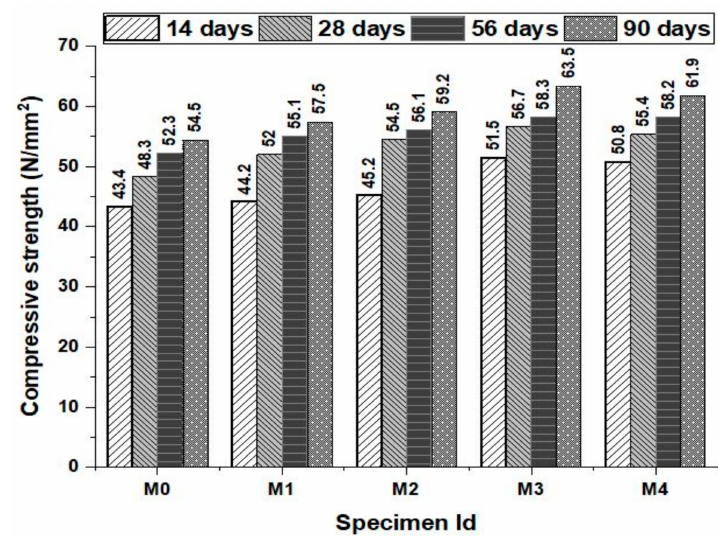
Figure 5. Compressive strength of the concrete mixes at various ages.